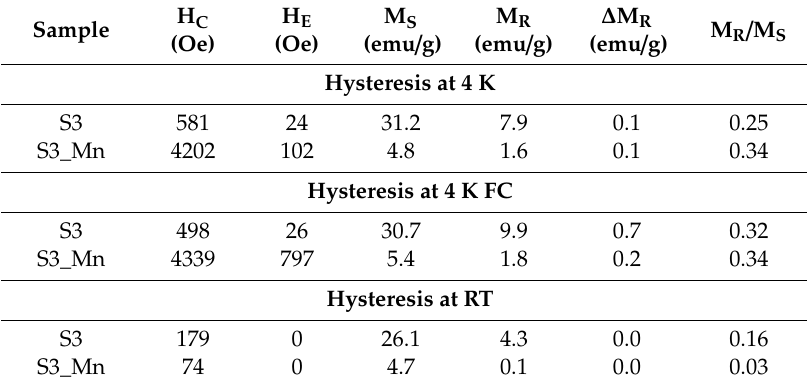
∆ M R (mean vertical shift of the hysteresis loop); M R